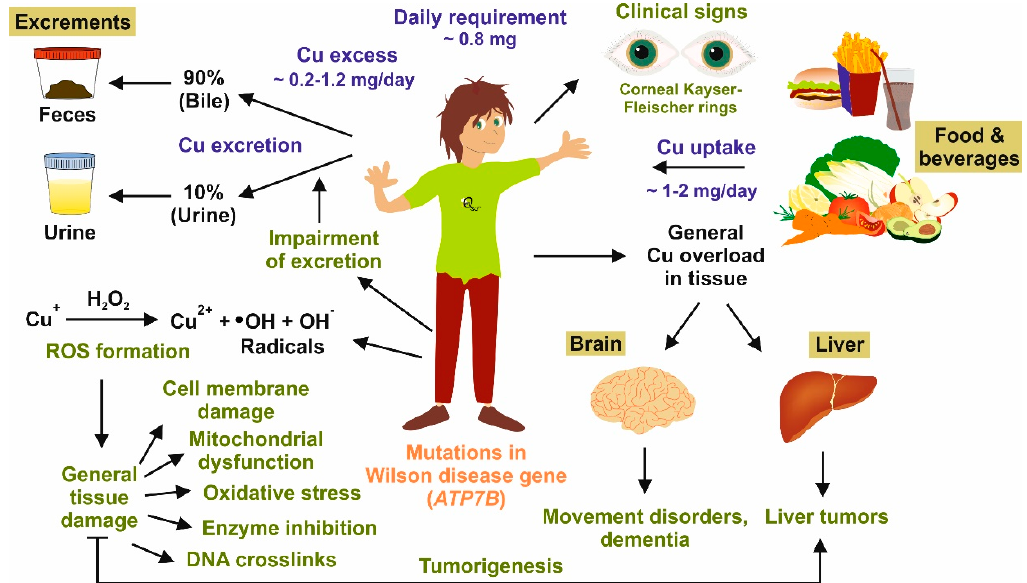
Figure 1. Body copper homeostasis and clinical manifestations in Wilson disease. Adults typically require ~0.8 mg Cu/day, while ingesting ~1.0–2.0 mg/day through food and beverages. The body excretes ~90% of excess Cu through the bile/feces and ~10% through the kidneys. In Wilson disease patients, the ATP7B gene is mutated resulting in Cu overload, inevitably leading to progressive liver and neurological dysfunction. Furthermore, Cu accumulation is associated with the generation of reactive oxygen species (ROS), mitochondria dysfunction, enzyme inhibition, cell membrane damage, and DNA modification. Clinically, Cu overload manifests in the occurrence of corneal Kayser–Fleischer rings, liver tumors, highly variable neurologic peculiarities, psychiatric abnormalities reflecting in movement disorders, and dementia.